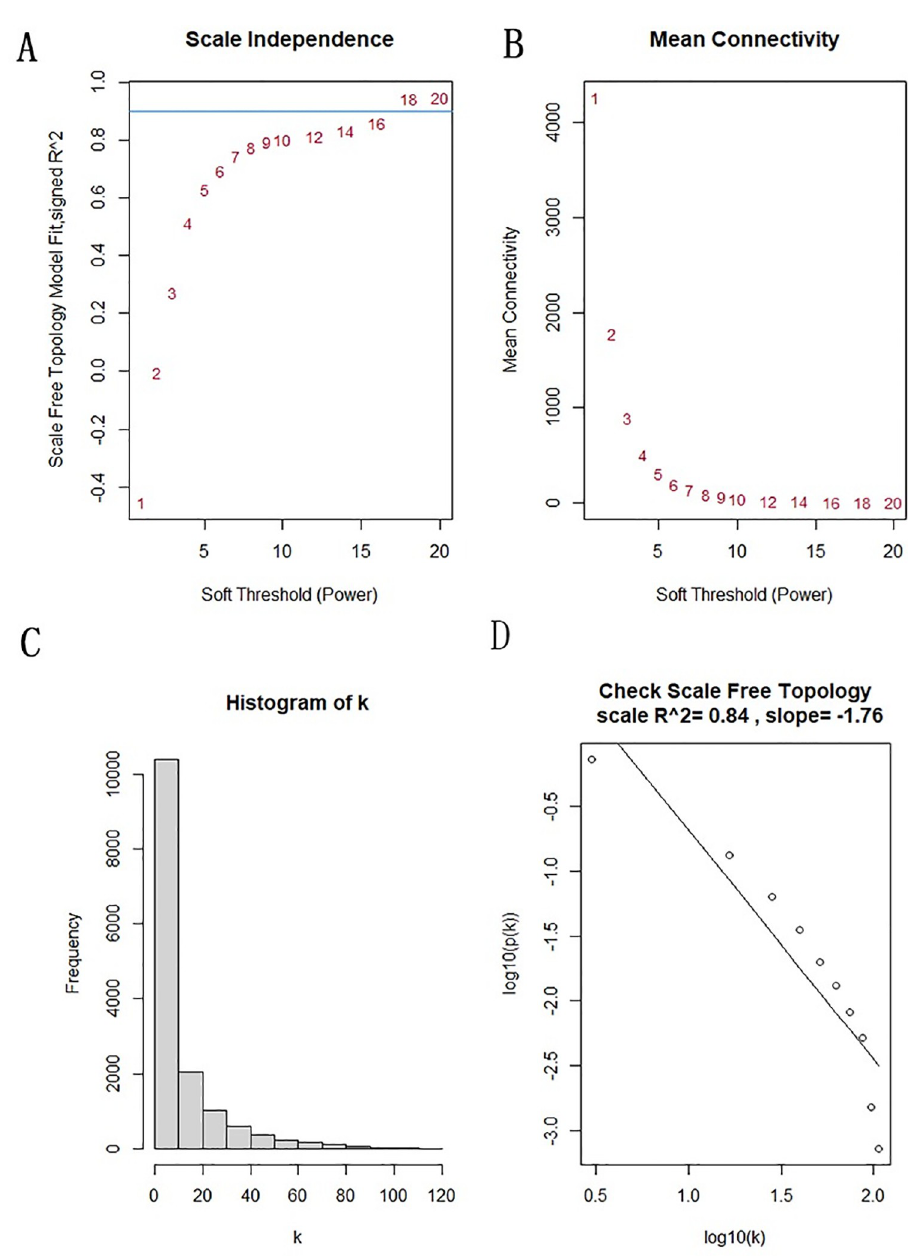
Fig 3. The screening criteria of WGCNA. (A)Soft Threshold (Power) represents the weight, and the vertical axis shows the scale-free topology fitting index R^2 (B) Soft Threshold (Power) represents the weight, and the vertical axis shows the average connectivity of the network (C) Distribution of node connectivity K (D) Correlation graph of K and P